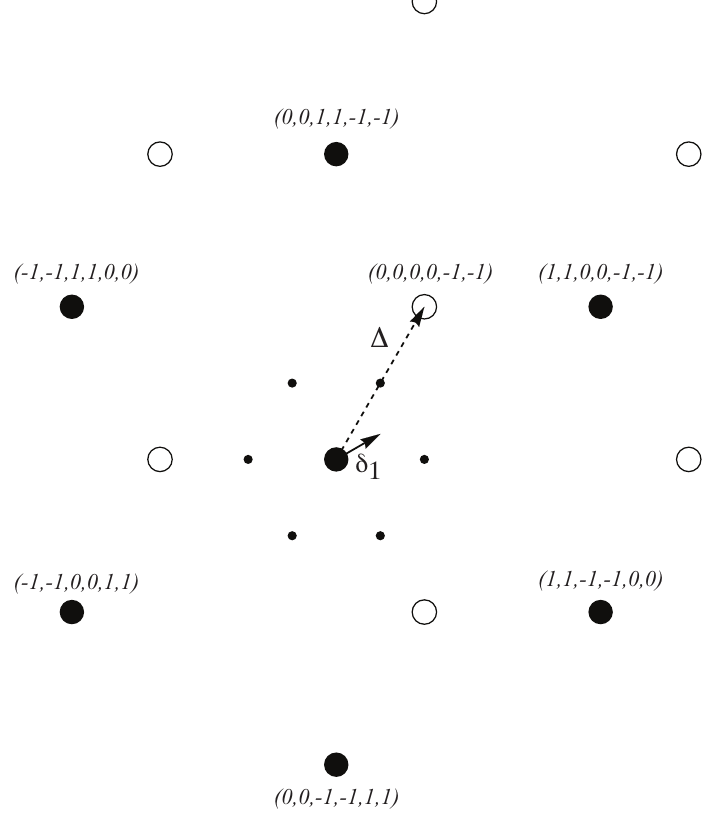
Figure 4. Description of the procedure to obtain a honeycomb by projection (details in the main